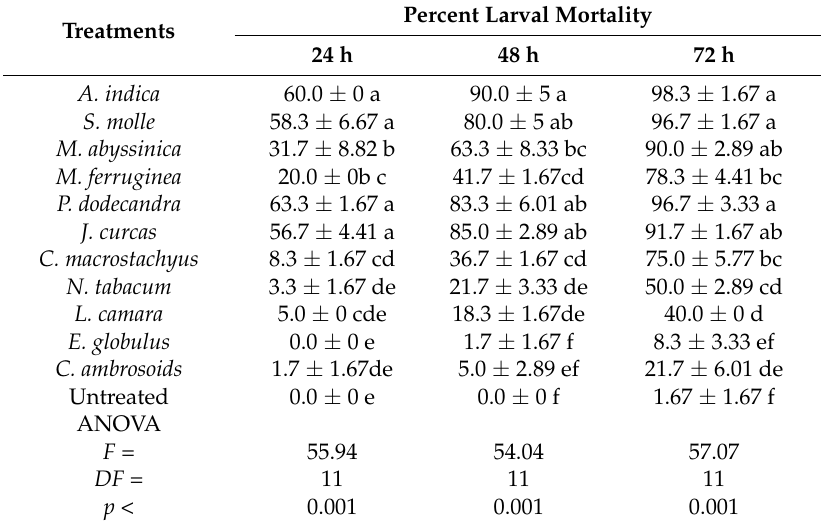
Table 6. Mean percentage ( ± SEM) of cumulative mortality of FAW larvae 24, 48, and 72 h after feeding on maize leaves treated with botanical extracts in the laboratory